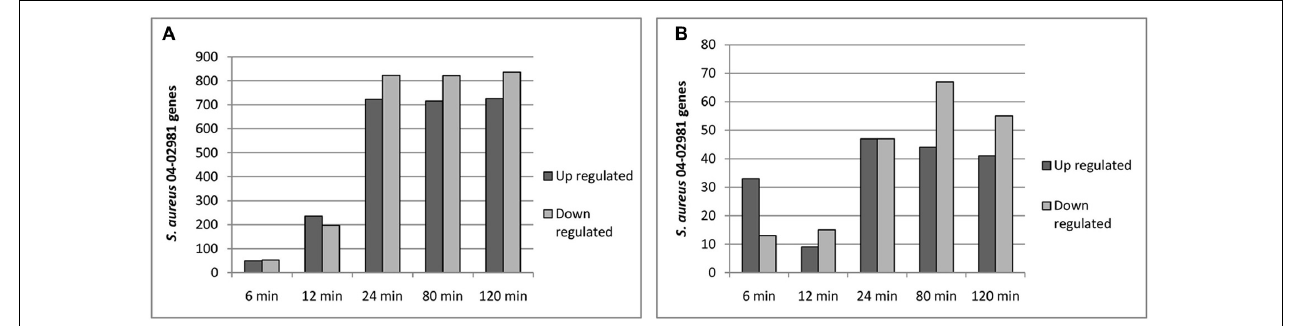
FIGURE 3 | (A,B) Show the number of differentially expressed genes in S. aureus 04-02981 on exposure to AGXX R (cid:13) (A) and Ag (B) for the indicated time-period, compared to control ( S. aureus 04-02981 grown without a metal sheet).